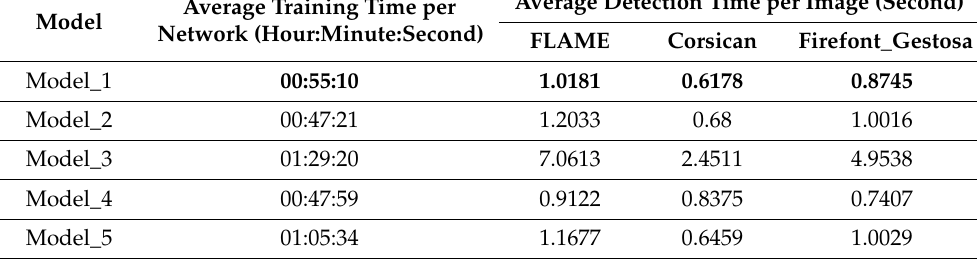
Table 6. Computational cost of the five previously selected models: Average values of training time per network and detection time per image per dataset. We note that we had averaged the results of five